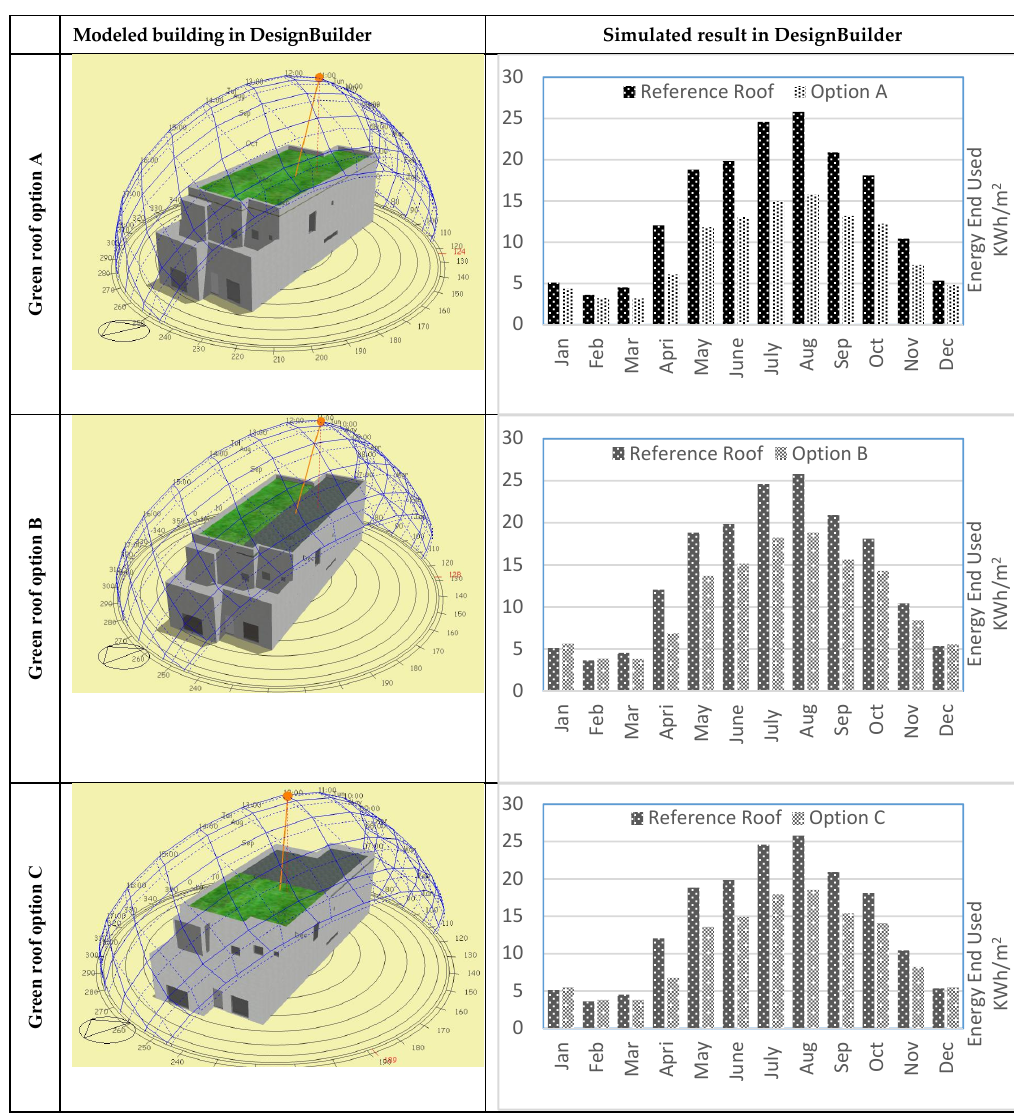
Figure 3. Simulated green roof options.